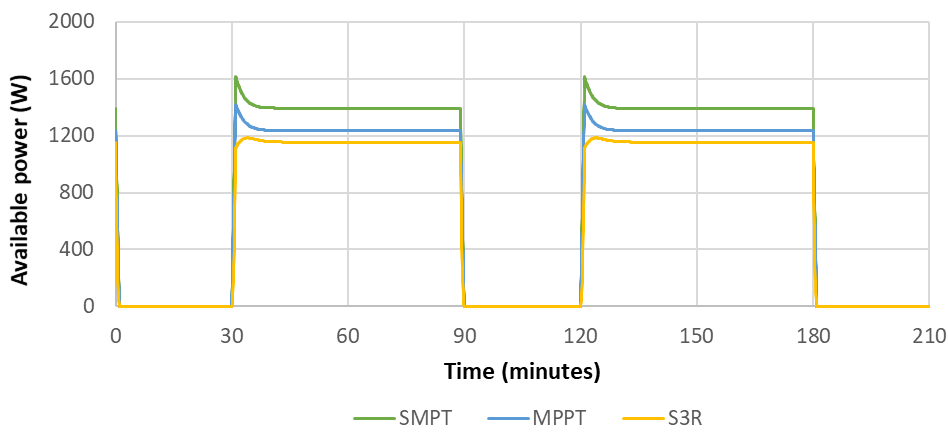
Figure 6. Available power from the solar array with the different regulation